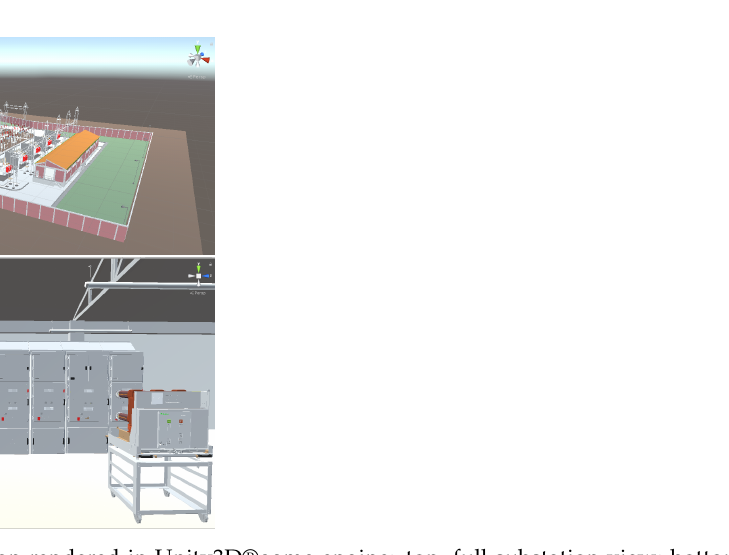
Figure 3. Substation rendered in Unity3D®game engine: top, full substation view; bottom, MV switchgear and spare circuit breaker in the control room.